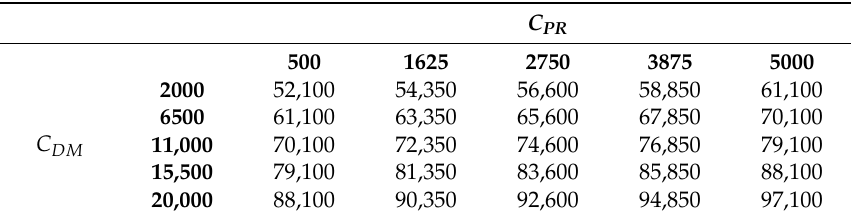
Table 2. Cost ( € ) analysis as a function of C DM and C PR Setup #2.